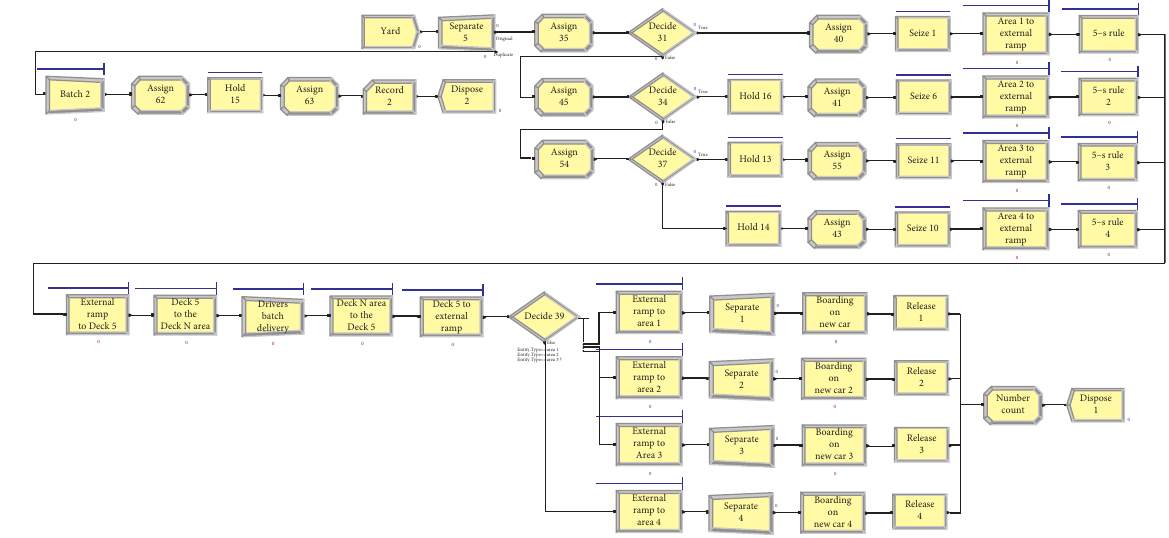
Figure 2: Simulation model of the current loading system in Arena (source: author).